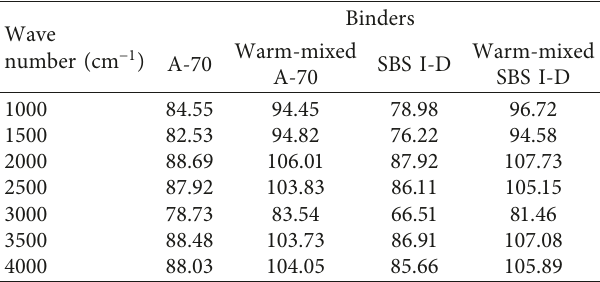
Figure 4: Infrared spectrum of EC-120. Table 4: Transmittances of base binder and warm-mixed binder (%).